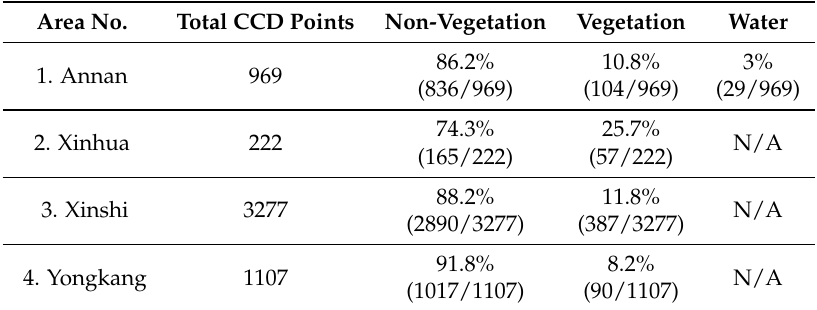
Table 4. The identifiable accuracy of CCD